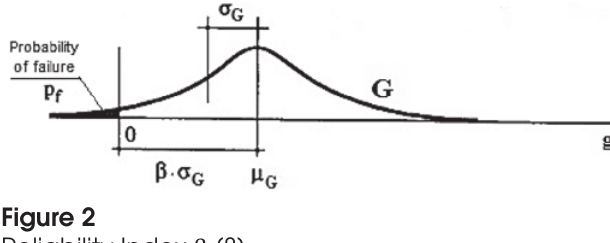
Figure 2 Reliability Index